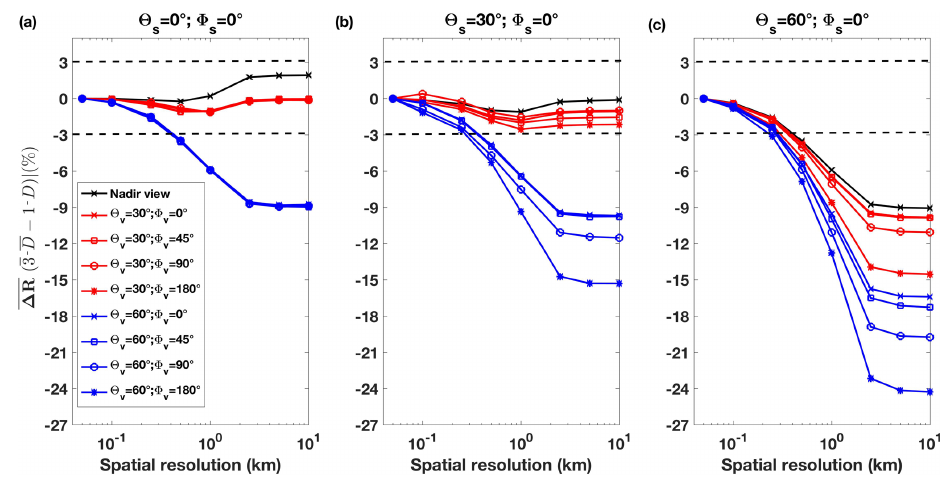
Figure 11. Plane-parallel and homogeneous bias (PPHB) representing by the arithmetic ( (cid:49)R( 1-D − 1-D ) ) differences in percentage between 1-D reflectances at 0 . 86µm relative to the 3-D reflectances in percentage, estimated with Eq. (3) as a function of the spatial resolution for various viewing zenith and azimuth angles (cid:50) v and (cid:56) v , respectively (black, red and blue colors), and solar zenith angles (cid:50) s (from the left to the right panels). The horizontal dashed lines represent the MODIS reflectance measurement uncertainty of 3% (Xiong et al., 2005,